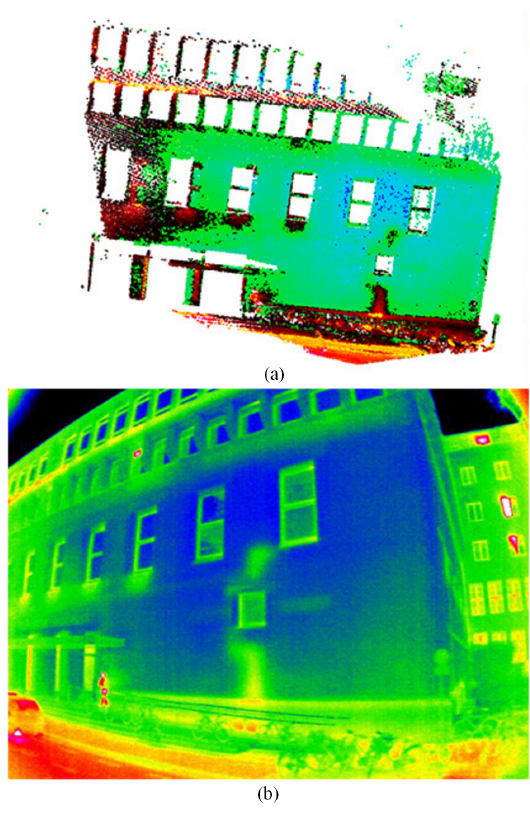
Figure 9. 3D thermographic model. (a) Generated model with false color. (b) Corresponding rectified image with false color (blue-low temperature, red-high